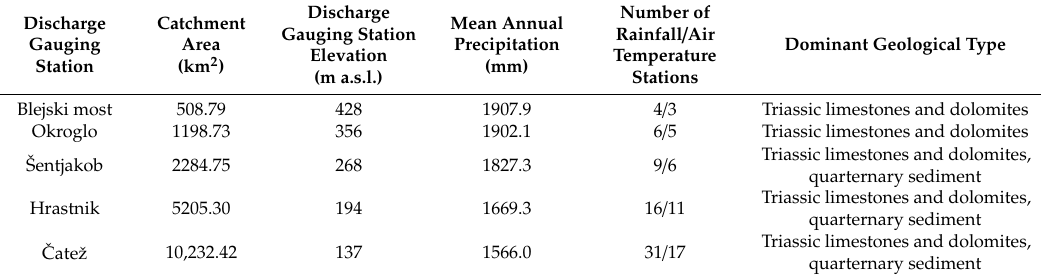
Figure 1. Location of the considered catchments on the map of Slovenia. Discharge gauging stations are indicated with red points. Rainfall and air temperature measuring locations are indicated with black and blue points, respectively. Table 1. Main characteristics of the analyzed catchments.